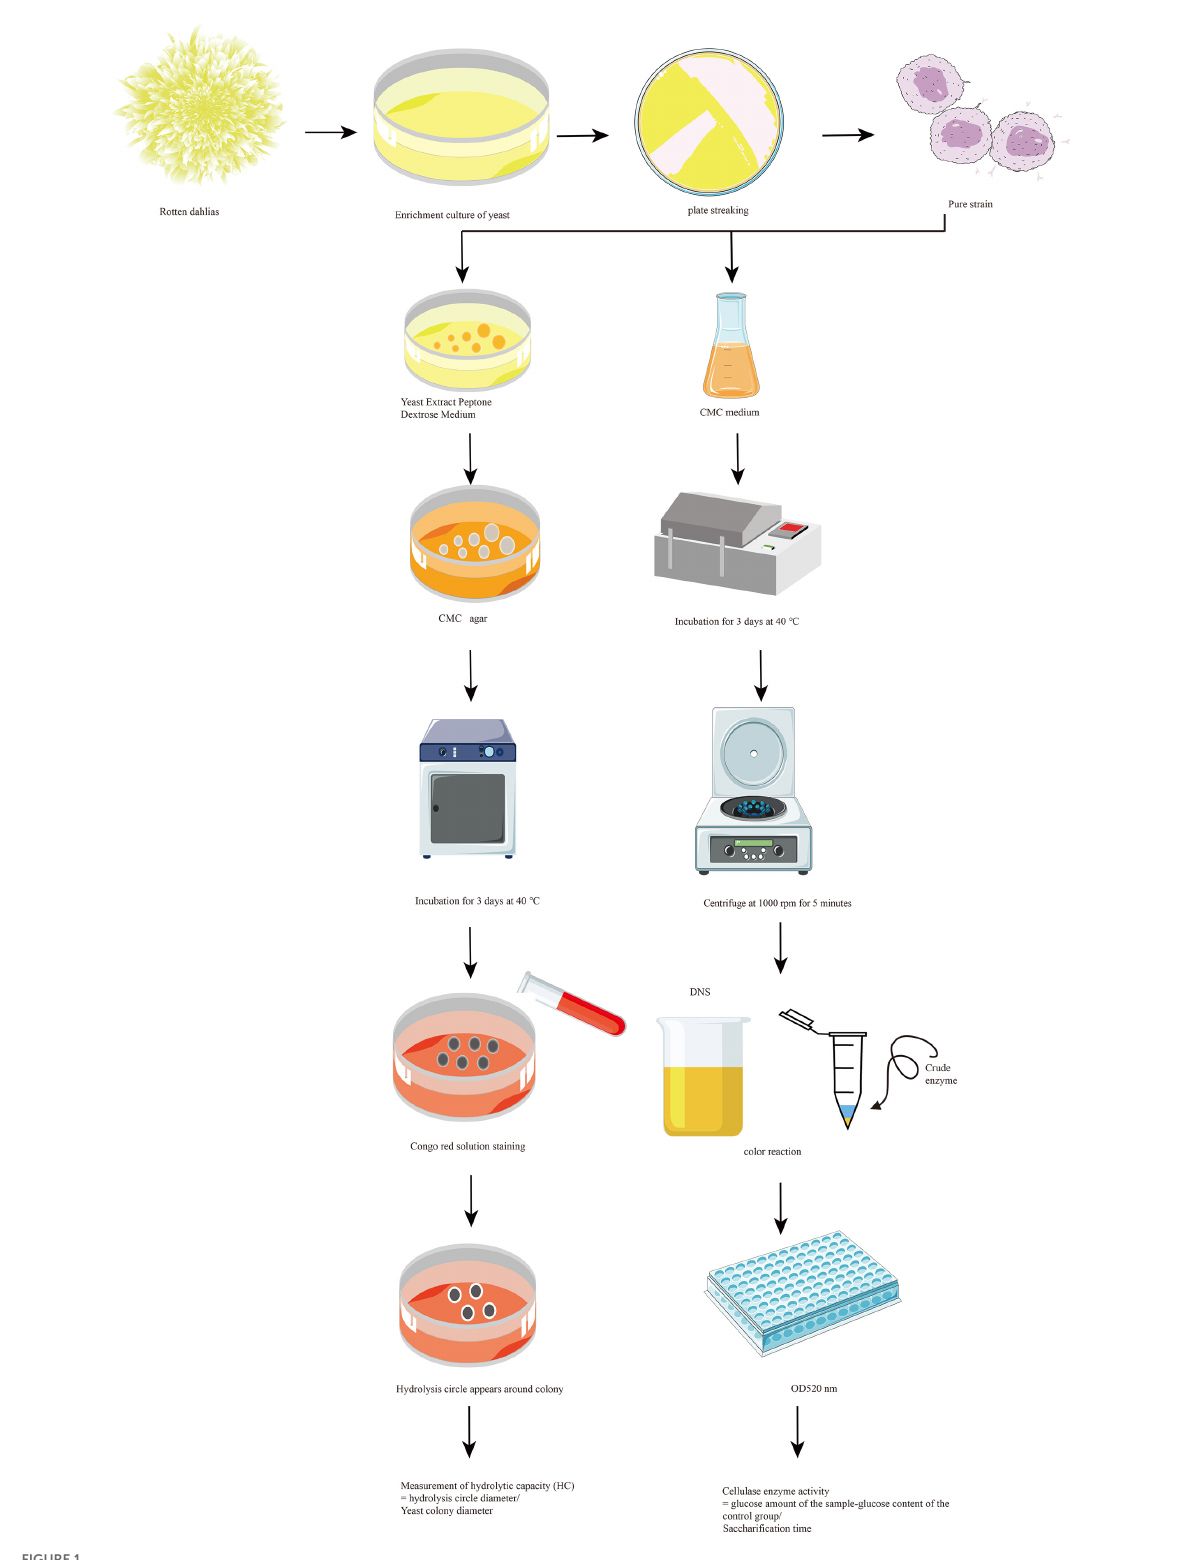
FIGURE1 Qualitative and quantitative screening of cellulose-degrading